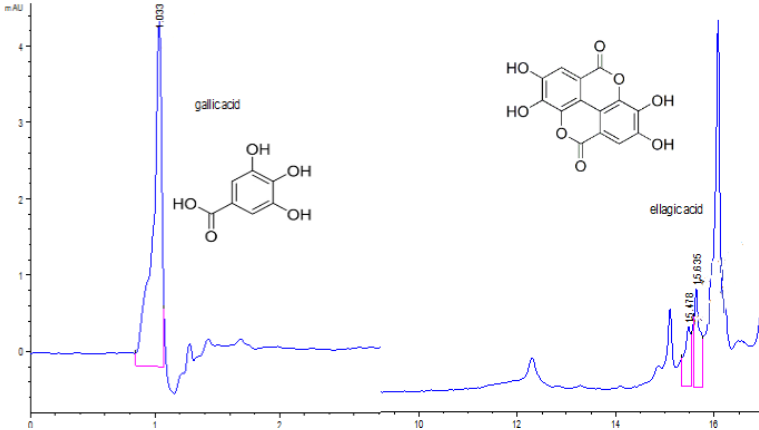
Figure 4. Gallic acid and ellagic acid in d UBE. The red lines mark the significant peak areas.